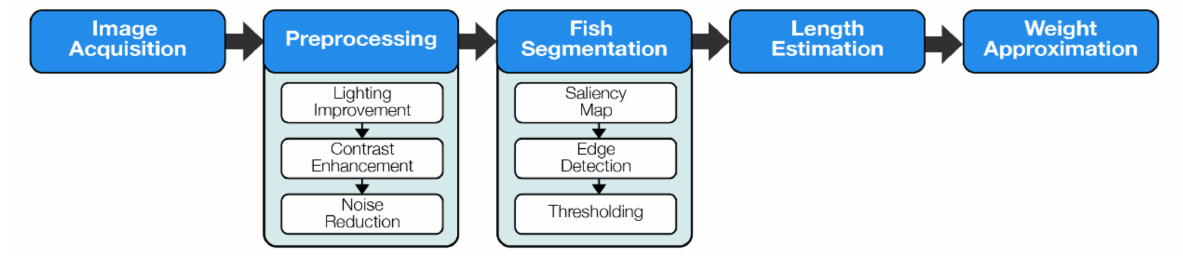
Figure 15. Outline of the procedures employed to segment fish.